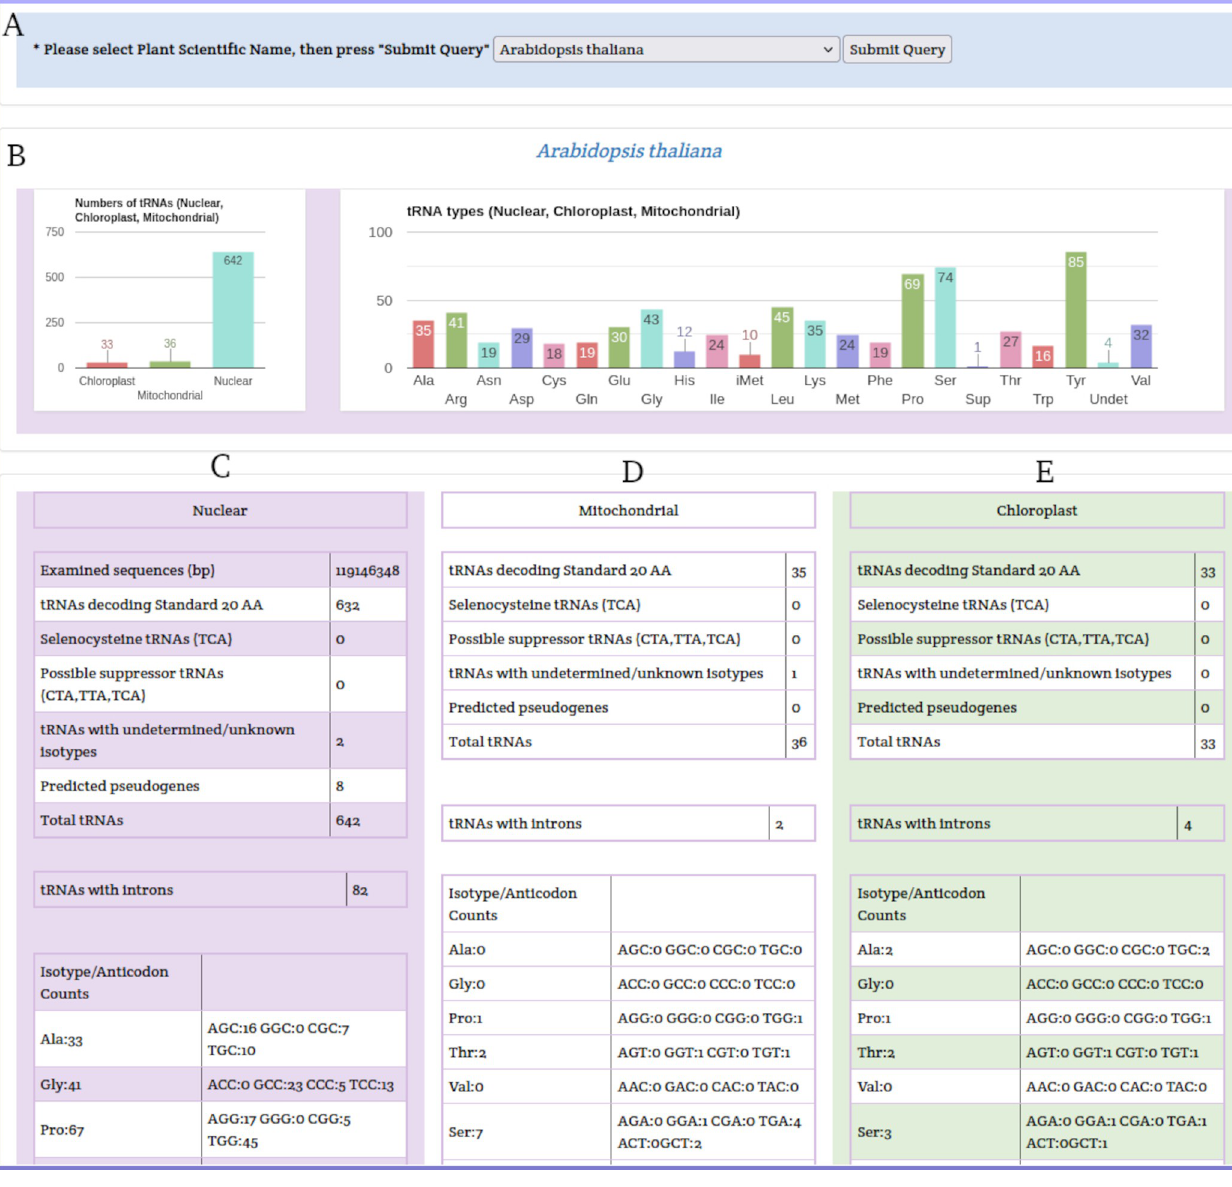
S1 Table. List of plant names, NCBI taxid, assembly type and level, sequence representa- tion, coverage, sequence category and accession numbers for all species examined.